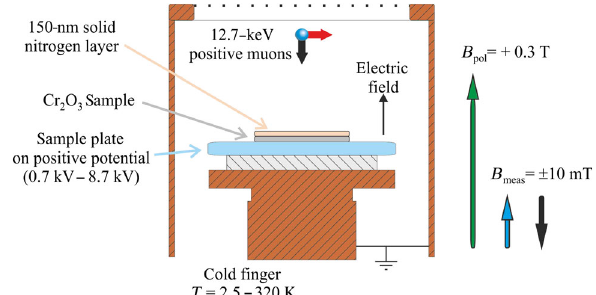
FIG. 5. Sketch of the LE- μ SR setup used for this experiment. Muons with a kinetic energy of 12.7 keVenter the sample region with nearly 100% spin polarization (red arrow). The energy of the muons impinging on the sample can be tuned by choosing the appropriate potential at the sample plate. The sample is cooled in 0 . 3 T and a positive electric field a positive poling field of B pol ¼ of E > 1 kV = cm to ensure a positive α . The measurements at low 10 mT. temperature are performed in B meas ¼ (cid:2)